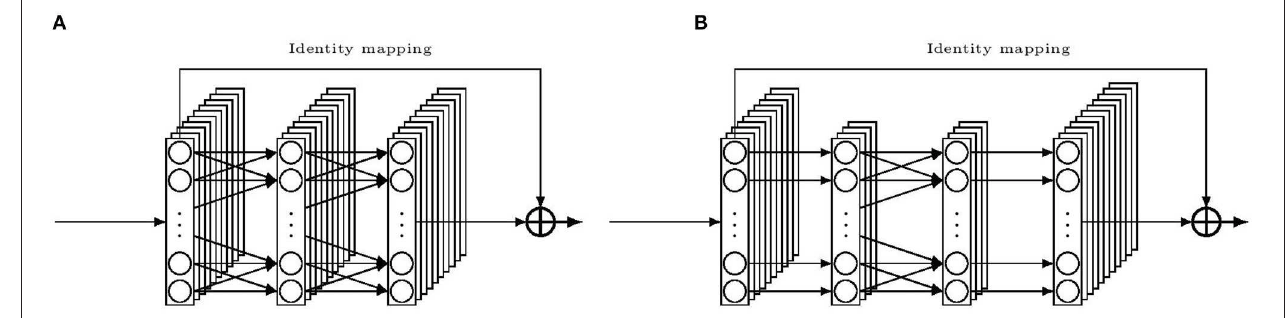
FIGURE 4 | Illustration of building blocks for the residual convolution network. (A) a residual building block. (B) a “bottleneck” residual building block.